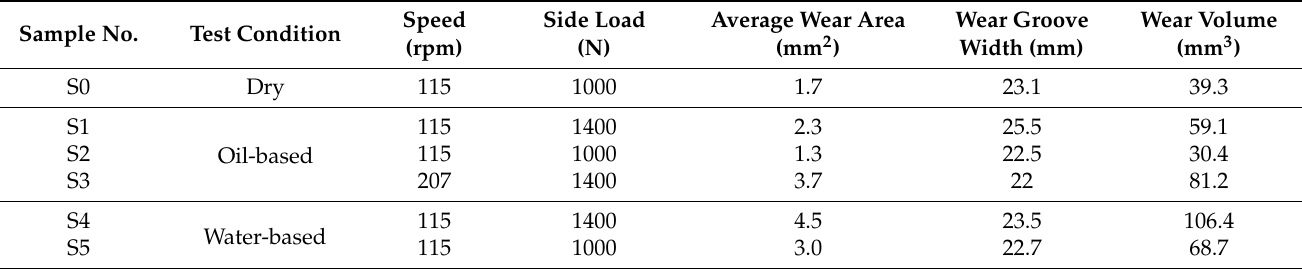
Table 2. Wear volume of the tested casing